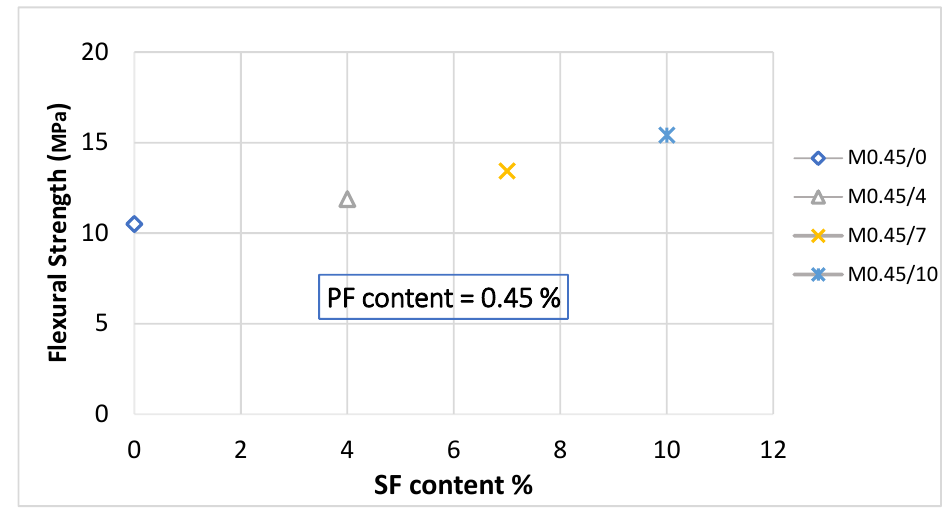
Figure 14. Effect of steel fiber content on flexural strength under ambient conditions.